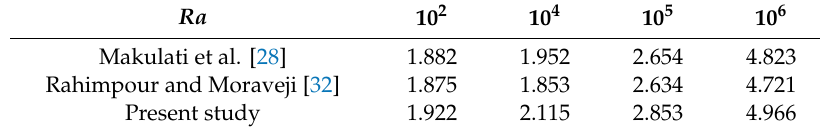
Table 6. Comparison of Nusselt numbers extracted from this study and previous studies.